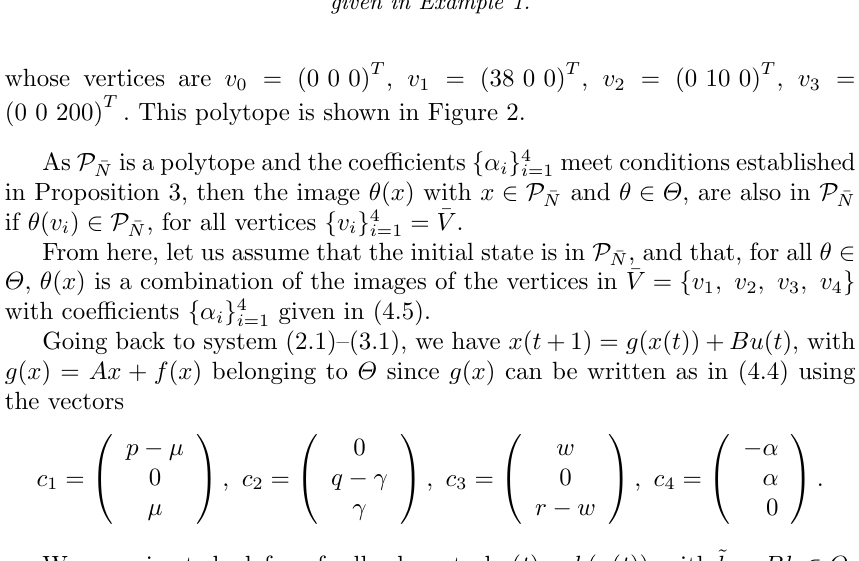
Figure 2. Polytope P ¯ N contained in set ˜ X corresponding to the parameters values given in Example 1.